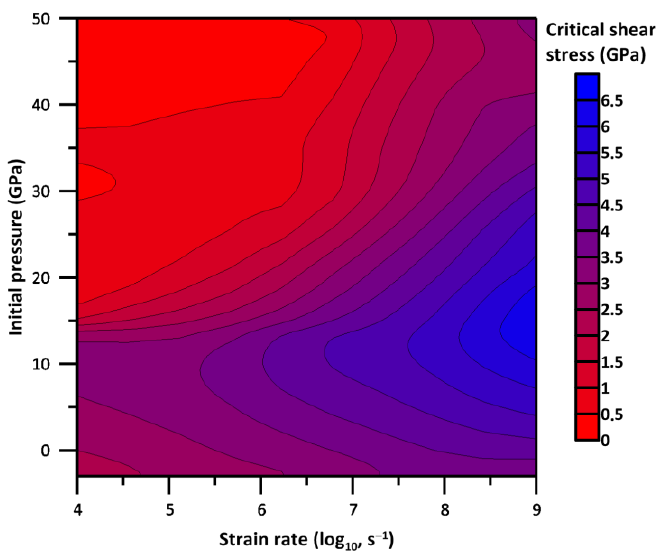
Figure 15. ANN-based prediction of the critical shear stress of plasticity incipience in the Al-Cu bisystem as a function of strain rate (presented by decimal logarithm) and the initial pressure.